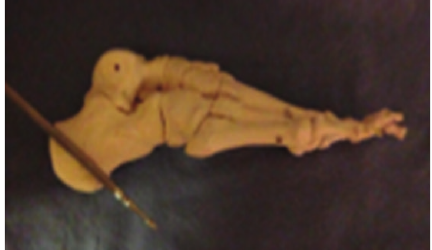
Figure 3: Category 1 partial calcanectomy: ≤ 50%